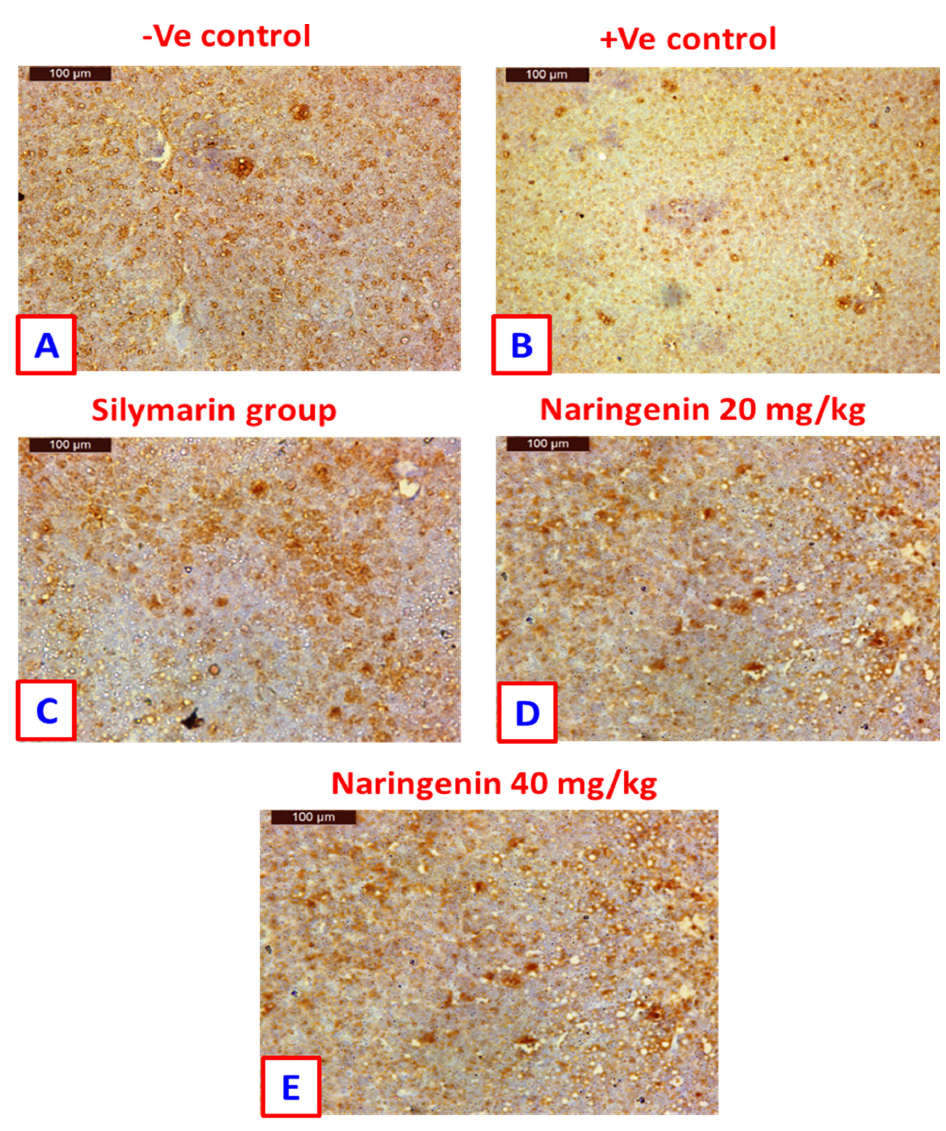
Figure 3. Immuno-histochemical detection of Bcl-2 in hepatocytes: ( A ) negative control rats showing positively stained hepatocytes (arrow), which are contrasted with non-staining nuclei (arrowhead); ( B ) positive control rat exhibiting negatively stained hepatocytes, which are contrasted with non- staining nuclei; ( C ) rat treated with silymarin drug showing more positively stained hepatocytes, which are contrasted with non-staining nuclei; ( D ) rat treated with naringenin (20 mg/kg), with positively stained hepatocytes contrasted with non-staining nuclei; ( E ) rat treated with naringenin (40 mg/kg), with positively stained hepatocytes contrasted with non-staining nuclei (immuno- histochemical expression of Bcl-2; scale bar: µ